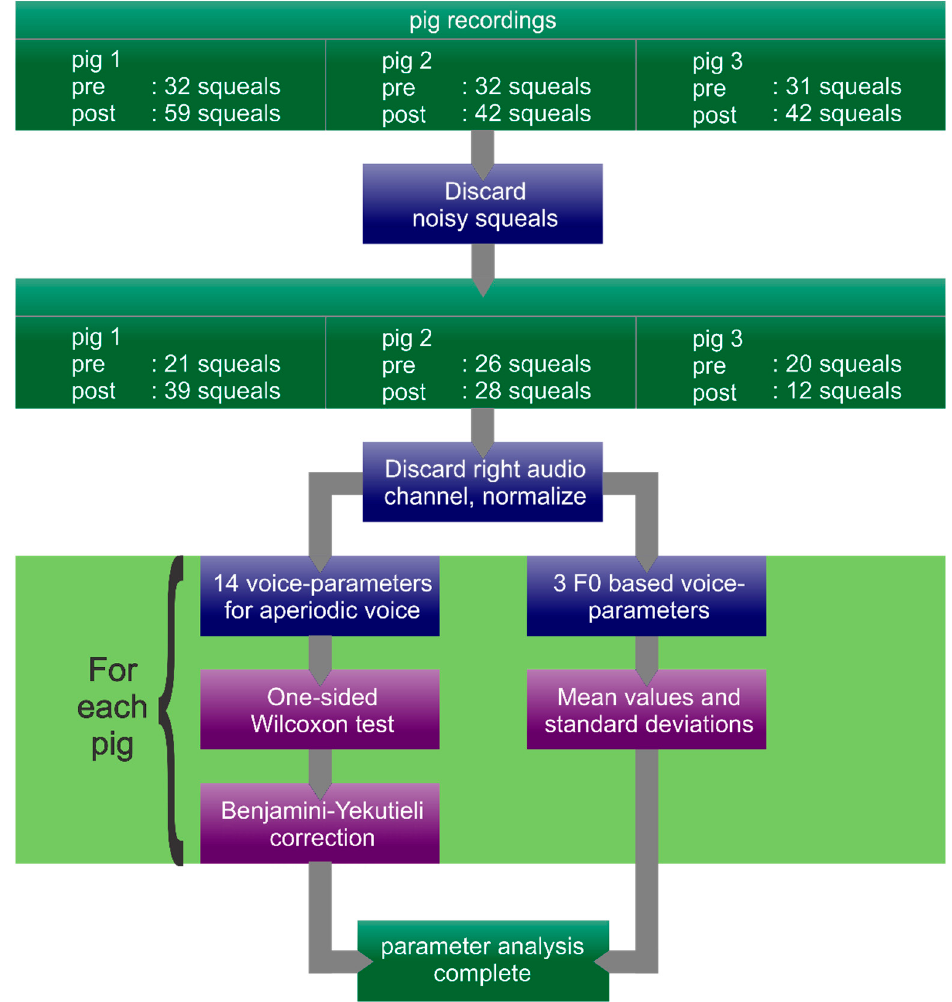
Figure 3. Step-by-step illustration of the data analysis process.